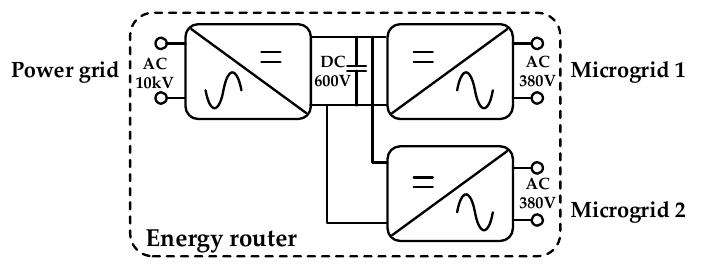
Figure 2. Schematic block diagram of the energy router.